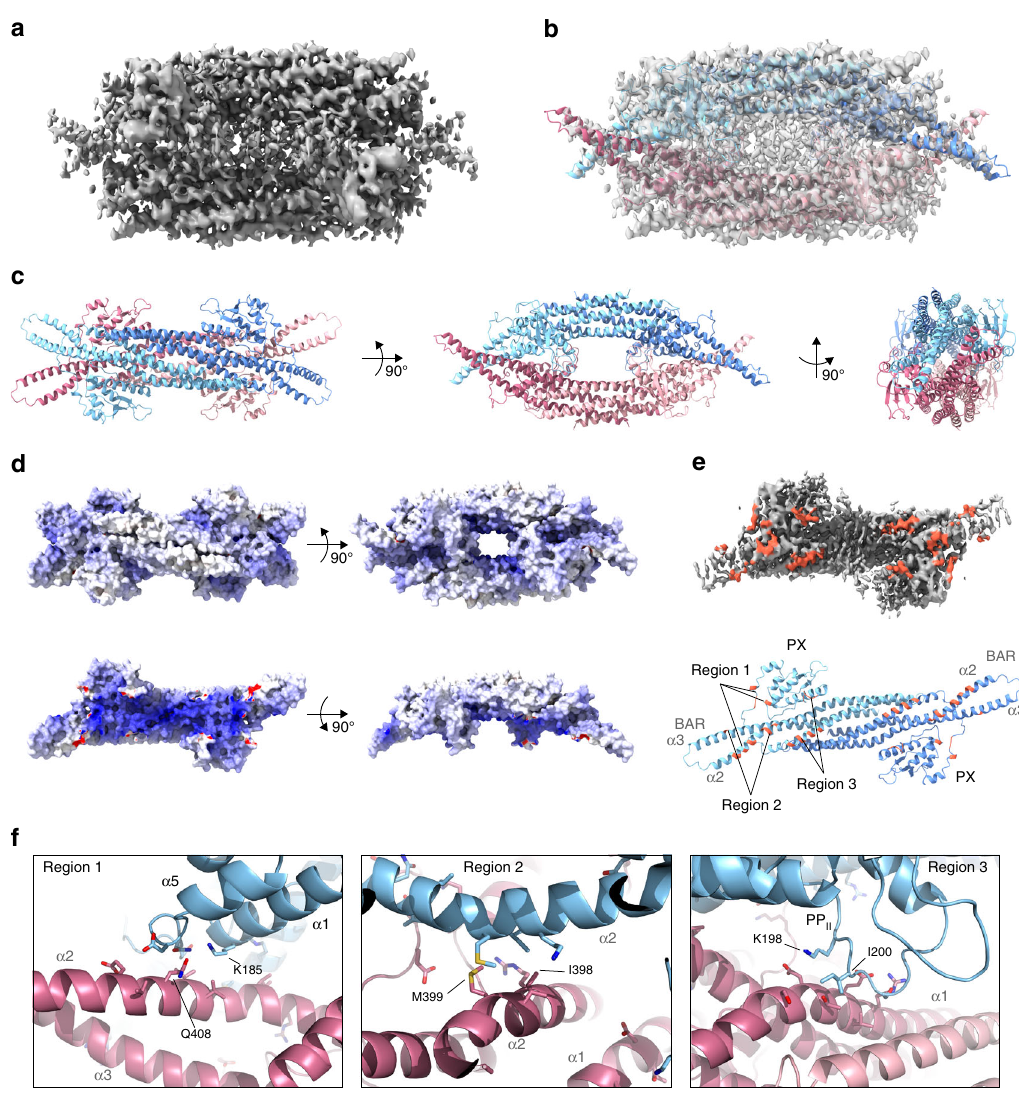
Fig. 2 The cryo-EM structure of the full-length Mvp1 tetramer. a Single-particle cryo-EM reconstruction of the Mvp1 tetramer. The D2-symmetrized, sharpened ( B = − 252 Å 2 ) map is shown at a contour level of 4 σ . b Map, as in a , overlaid with a real-space re fi nement model of the Mvp1 tetramer. The upper Mvp1 SNX – BAR dimer is colored lighter and darker blue while the lower dimer is colored lighter and darker pink, to facilitate differentiation of the monomers. c Ribbon diagrams of the Mvp1 tetramer, colored as in b , viewed along each of the three twofold axes in the structure. d Surface models of the Mvp1 tetramer colored by electrostatic potential, colored from red (negative) to blue (positive). The scale is − 25 to 25 kT / e . Upper row: the Mvp1 tetramer. Lower row: an isolated Mvp1 dimer. Note the sequestration of the positive charged concave surfaces into the interior of the tetramer. e Contact sites between the Mvp1 dimers responsible for tetramerization. Upper: map segment corresponding to the Mvp1 dimer with the contact sites between dimers colored in tomato. The map segment, extracted from the map presented in a and contoured at 4 σ , is oriented with the concave surface of the BAR dimer facing the reader. Lower: ribbon model of the Mvp1 dimer with the contact sites colored in tomato, oriented as for the map segment. f Details of the three tetramerization regions. In these cases, the trans dimer is also shown, in pink, as in c